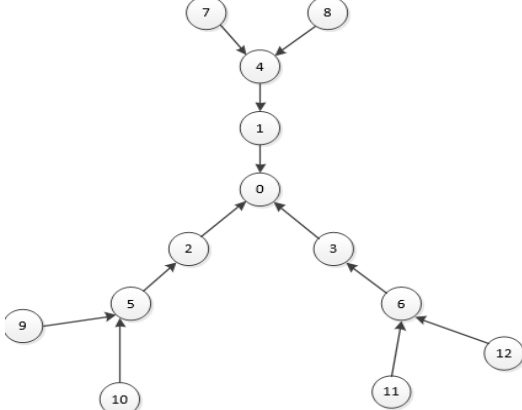
Figure 12. Aggregation network topology.